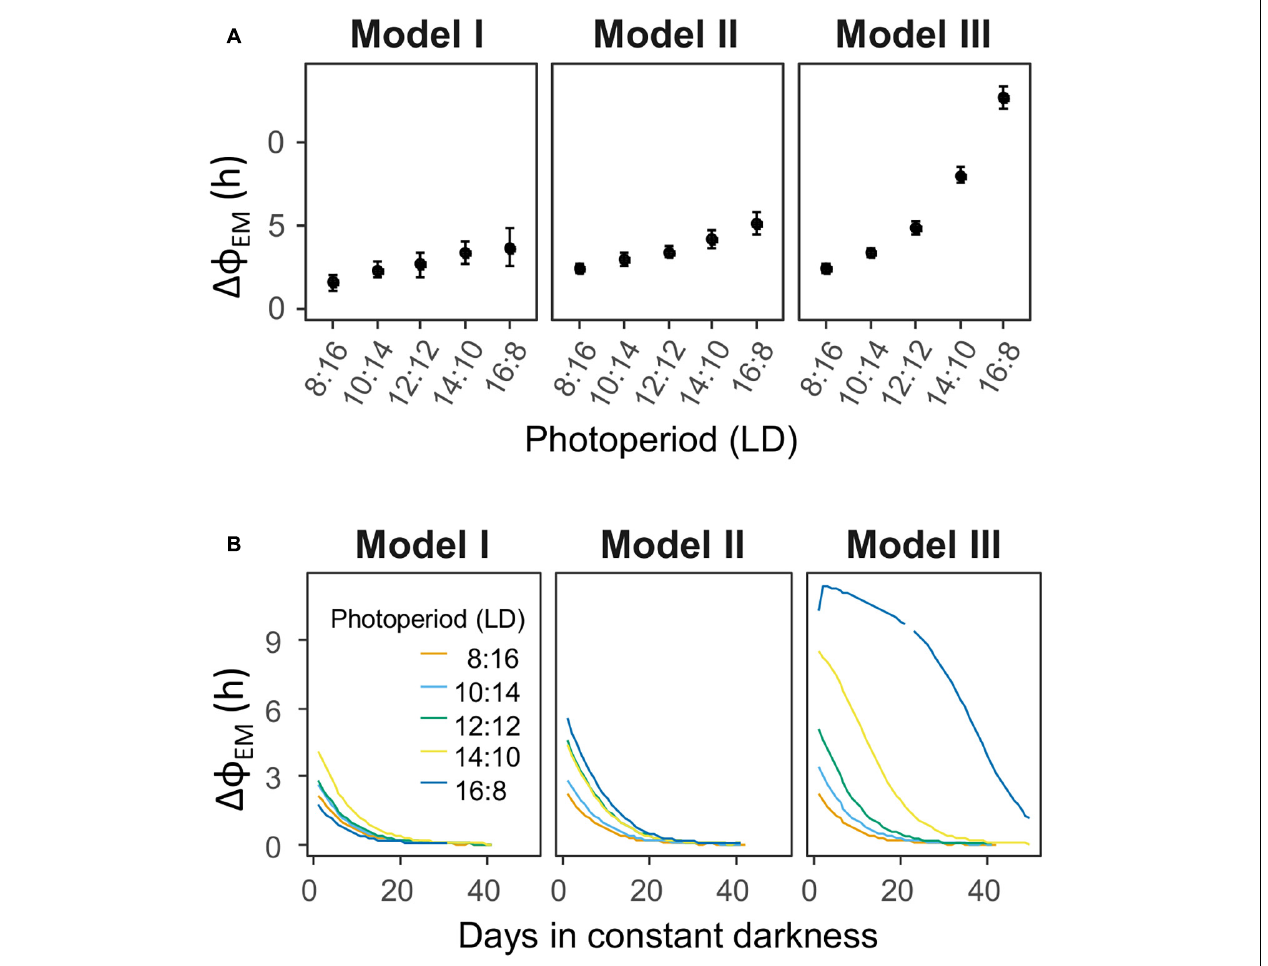
FIGURE 7 | Quantifications of the phase relationships between E and M ( (cid:49)(cid:56) EM ) in the 3 models, during the light exposure, and afterward in constant conditions. (A) Average (cid:49)(cid:56) EM in the last 20 days of light pulses, under different photoperiods. (B) Progression of (cid:49)(cid:56) EM along the days in constant conditions (DD), after termination of the pulses. The initial values in constant conditions reveal aftereffects of the previous entrainment to the distinct